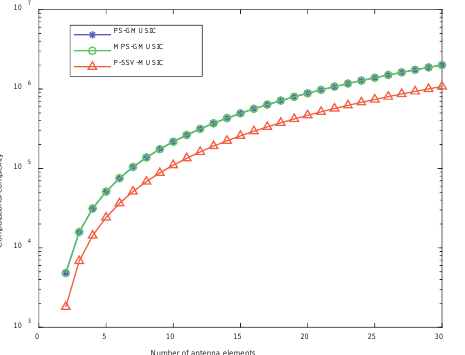
( b ) Figure 2. Spectrum estimation of the three methods when SNR